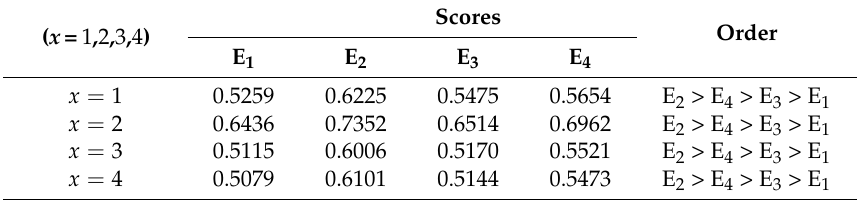
Table 4. Ranking results by utilizing a different parameter vector x in the IVPFWHM operator.